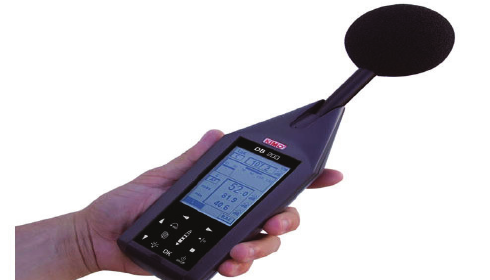
Figure 2 – Phonometer (http://www.3me.rs/portfolio-item/db-200-profesionalni-merac- nivoa-buke-sa-pc-interfejsom, 2016) Рис . 2 – Фонометр (http://www.3me.rs/portfolio-item/db-200-profesionalni-merac-nivoa- buke-sa-pc-interfejsom, 2016) Слика 2 – Фонометар (http://www.3me.rs/portfolio-item/db-200-profesionalni-merac- nivoa-buke-sa-pc-interfejsom,